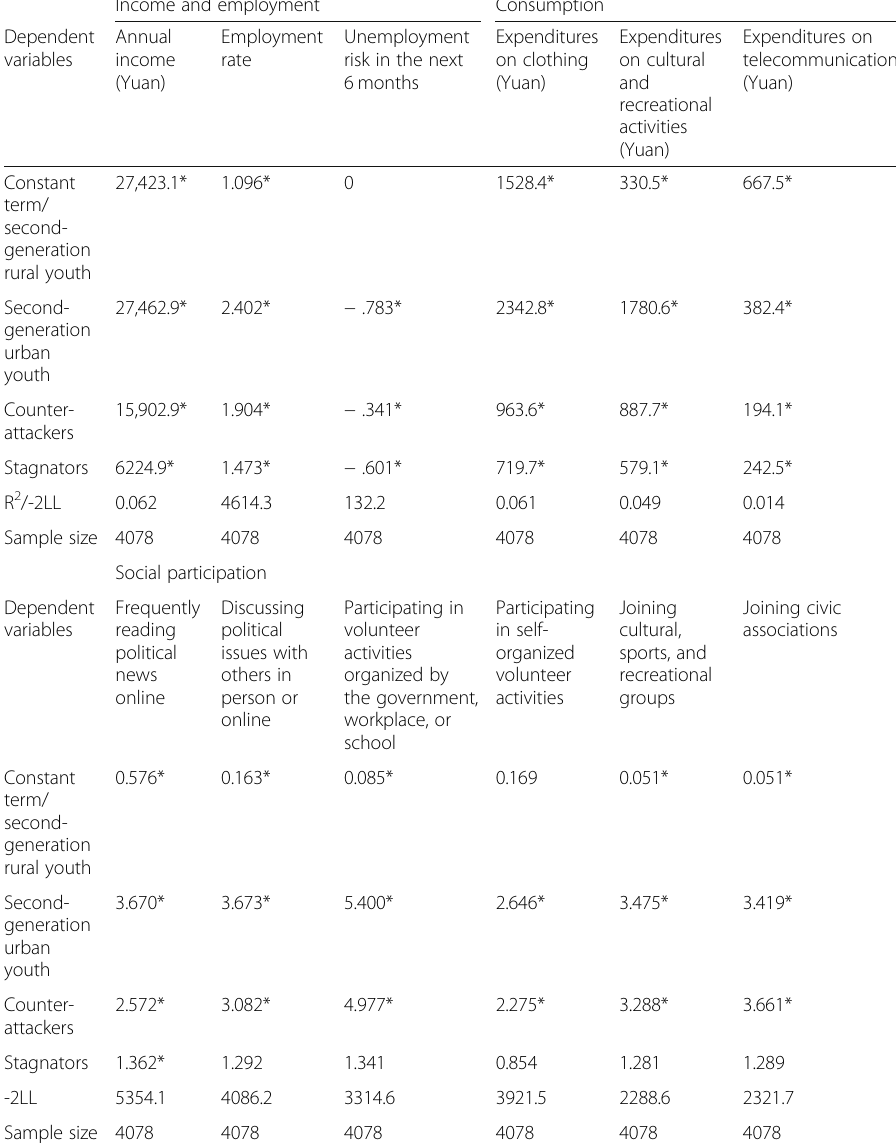
Table 4 Socioeconomic stratification of China ’ s new generation (results of regression